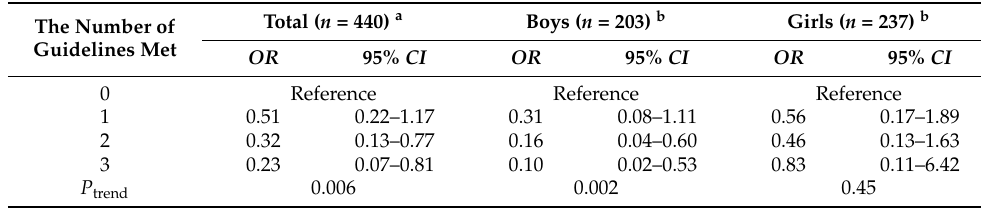
Table 4. Associations between the number of guidelines met and overweight and obesity in Chinese children and